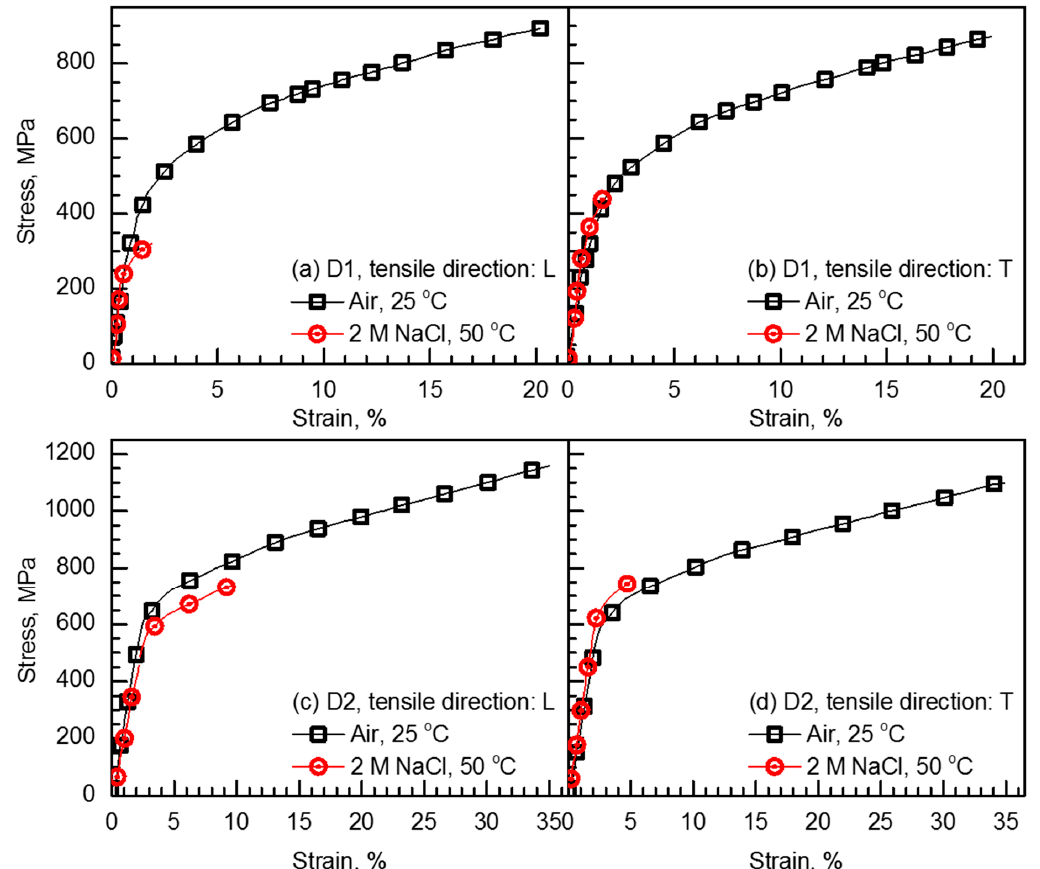
Figure 6. Stress-strain curves (strain rate = 10 − 6 s − 1 ) of ( a , b ) D1 and ( c , d ) D2 alloys obtained in air at 25 °C and 2 M NaCl solution at 50 °C under anodic applied potential of +0.05 V versus E corr . The SSRTs 25 ◦ C and 2 M NaCl solution at 50 ◦ C under anodic applied potential of +0.05 V versus E corr . The SSRTs were conducted along ( a , c ) L- and ( b , d ) T-directions. were conducted along ( a , c ) L- and ( b , d )